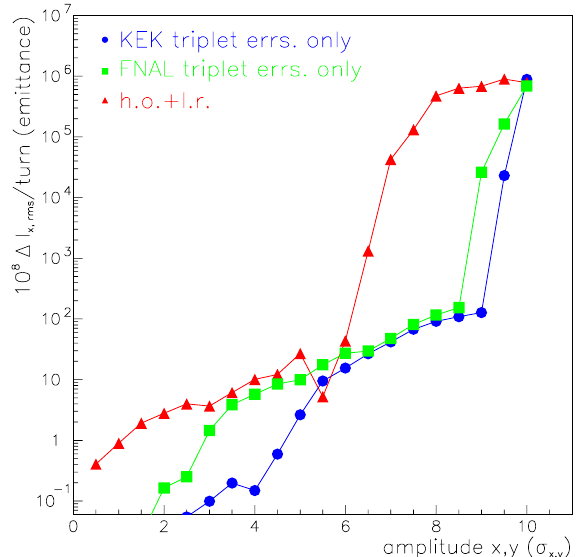
FIG. 9. (Color) The change of action variance per turn as a function of the starting amplitude. Compared are the effect of beam-beam collisions with that of the KEK and FNAL triplet field errors.